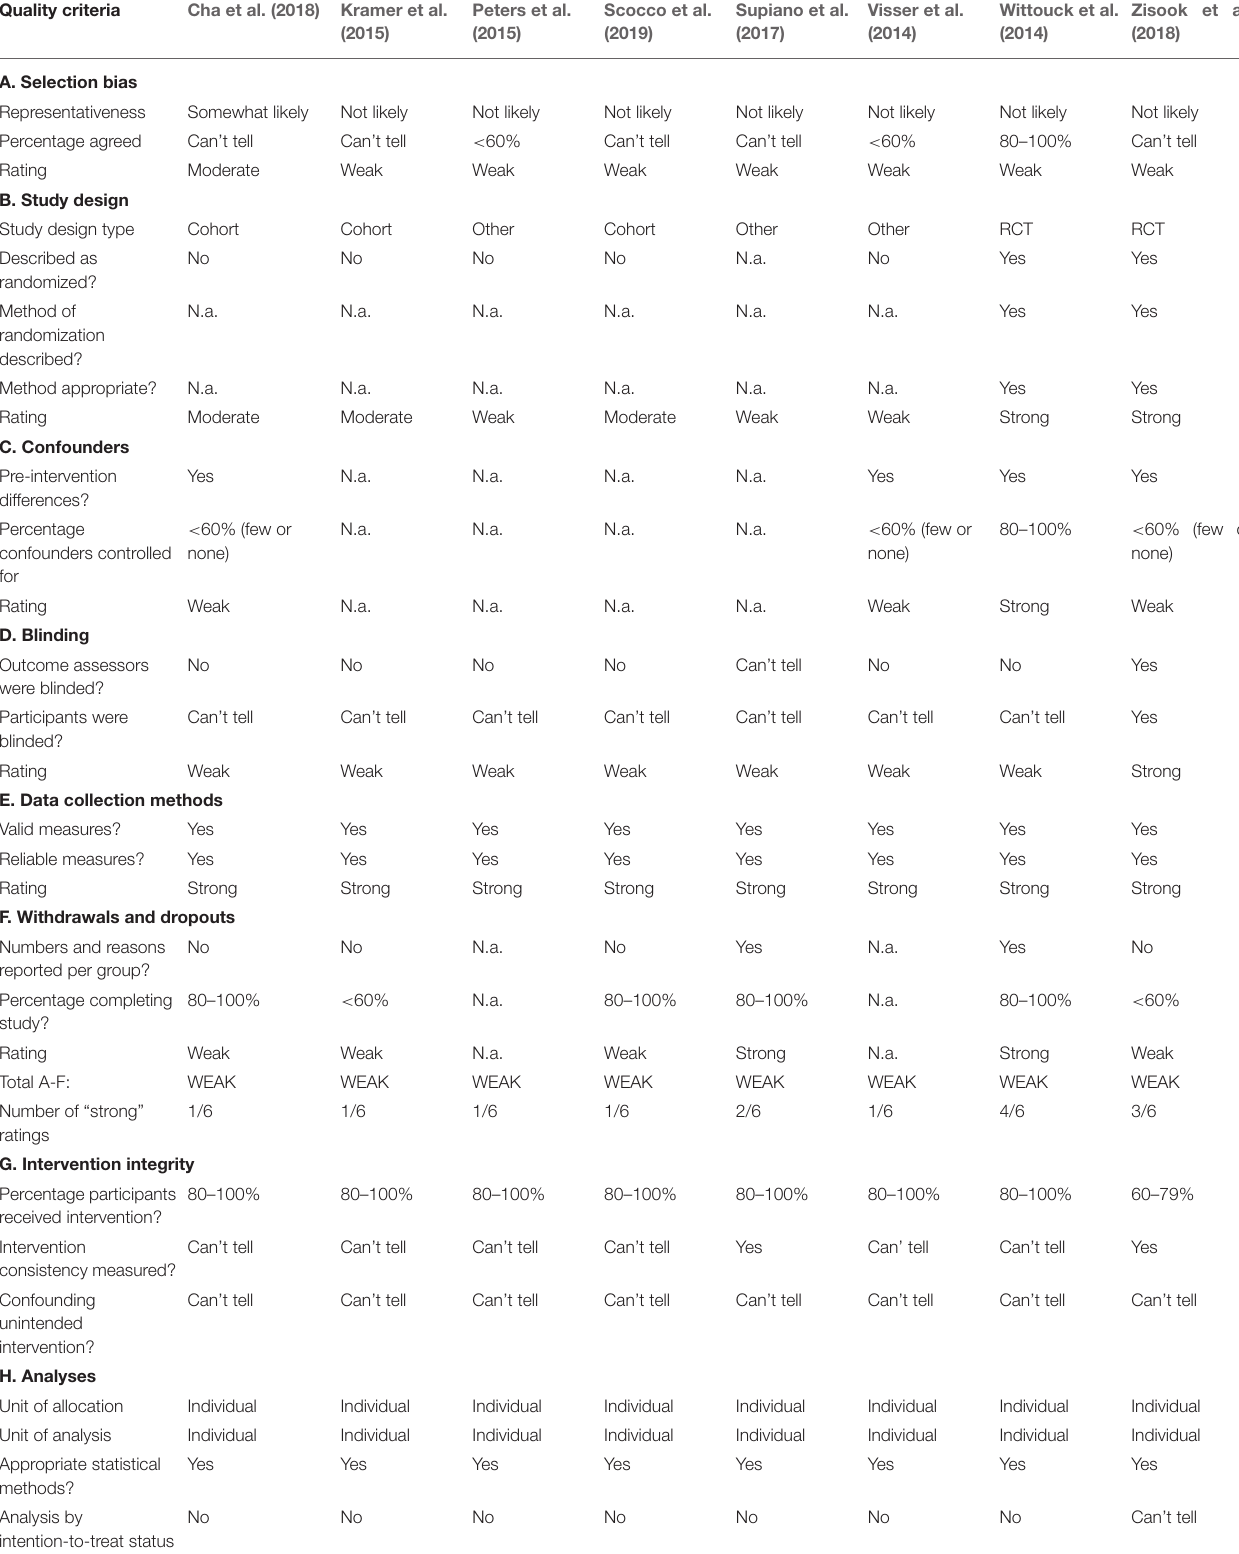
TABLE 4 | Summary of study